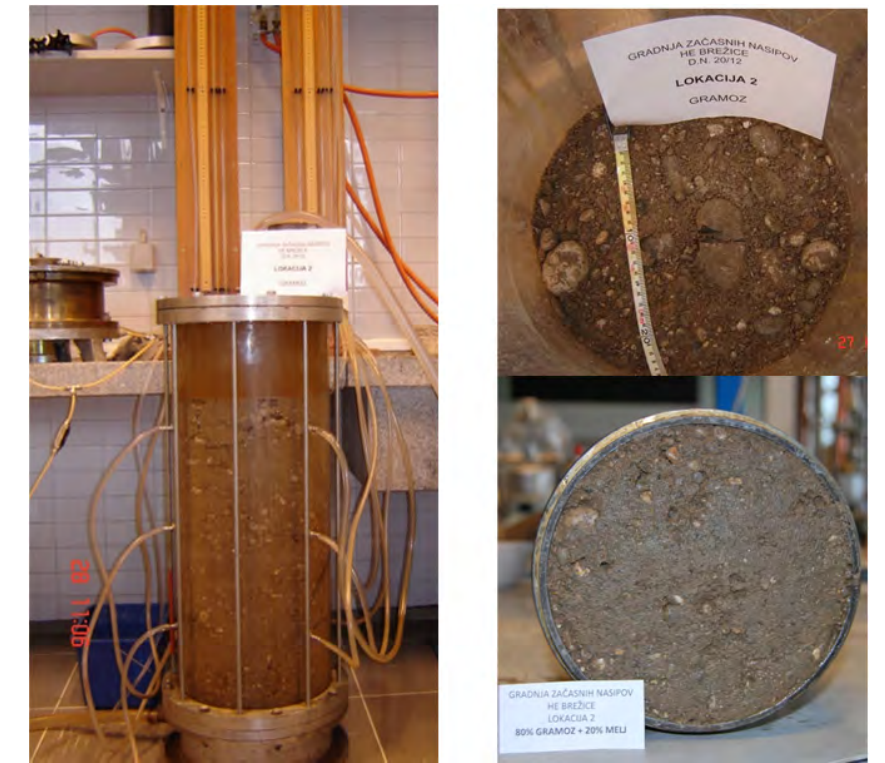
Figure 23. A view to the permeameter cell (left) and a view to the surface of gravel and mixture (right).